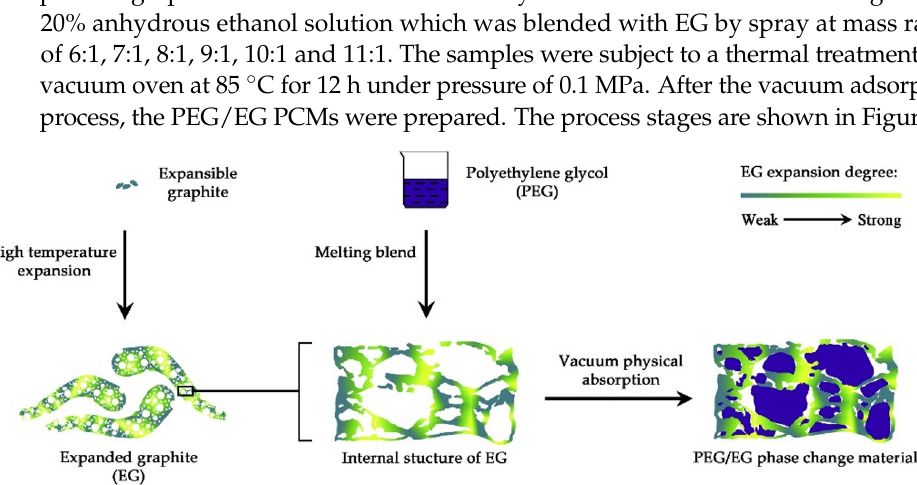
Figure 18. Preparation of the Kaol-nanotubes process [82]. Reproduced with permission from Elsevier. B.